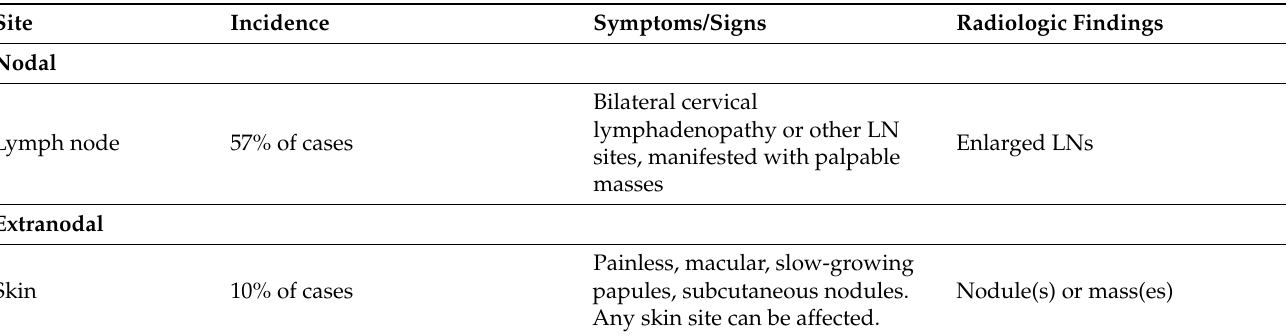
Table 1. Clinical Symptoms and Signs of Nodal and Extranodal RDD—Organ and Tissue Specified